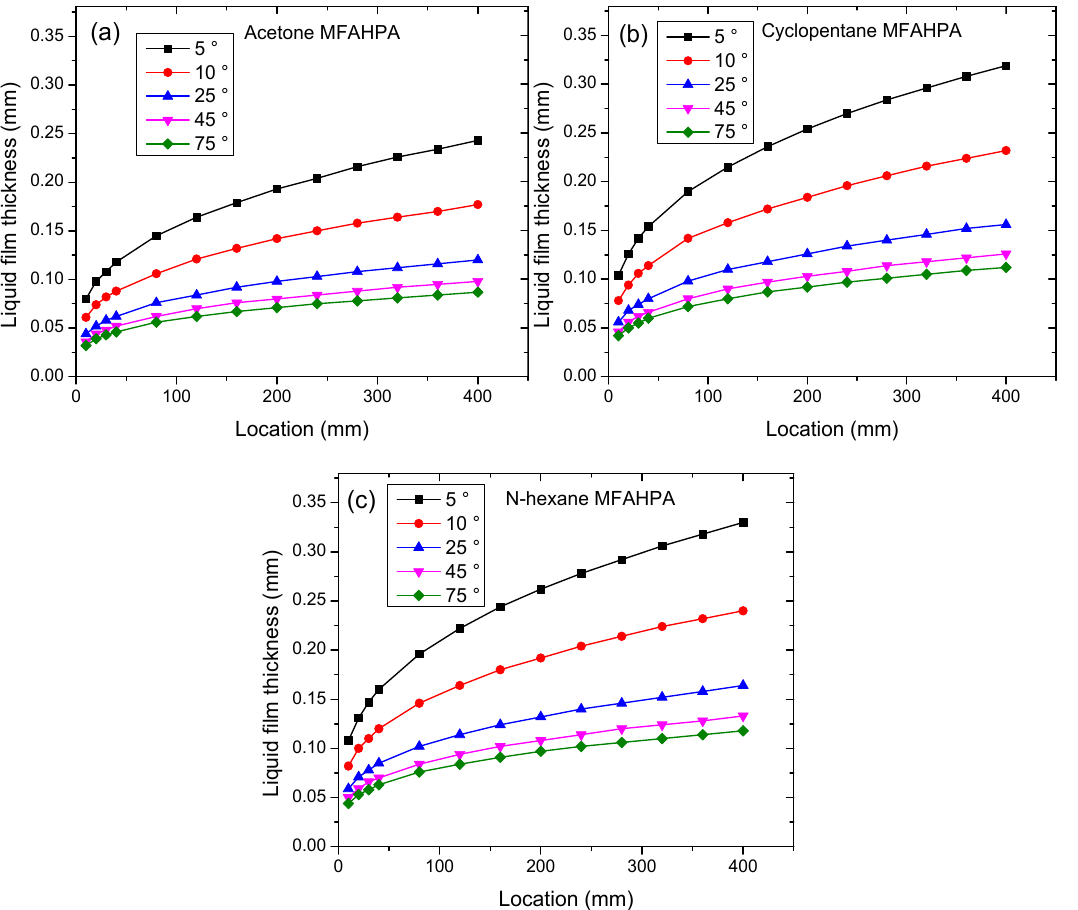
Figure 11. Effect of inclination angle on the liquid film profile in the condensation section. ( a ) Acetone MF-AHPA; ( b ) cyclopentane MF-AHPA; and ( c ) n-hexane MF-AHPA. All of the heat pipes are at a heat load of 90 W.